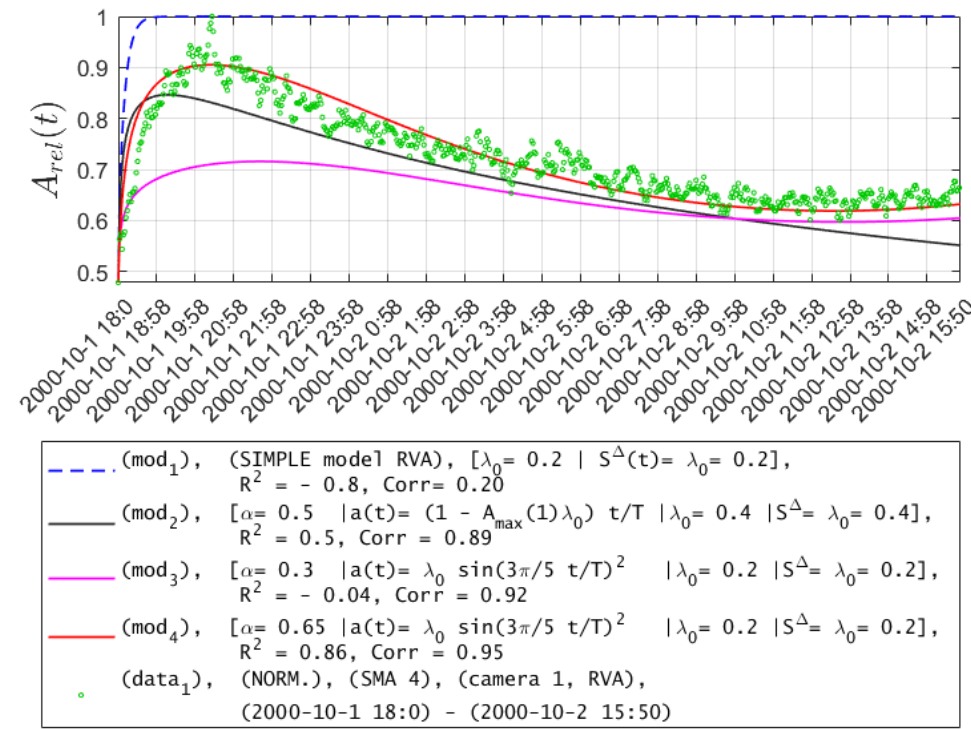
Figure 9. Data on radon accumulation in the chamber on GLLR (green points) and model data with different model parameters.